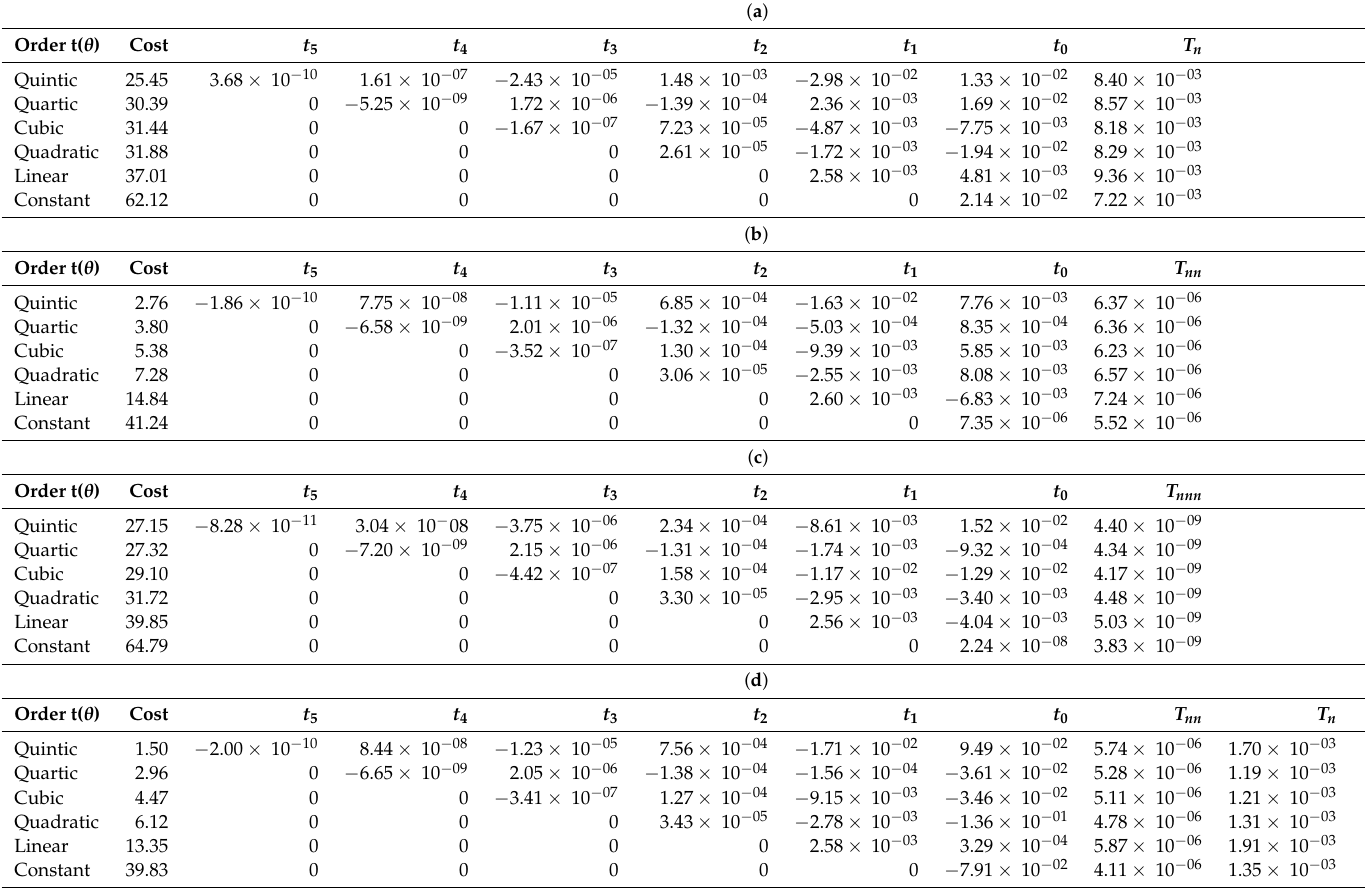
Table A3. Identified thrust model coefficients of Table